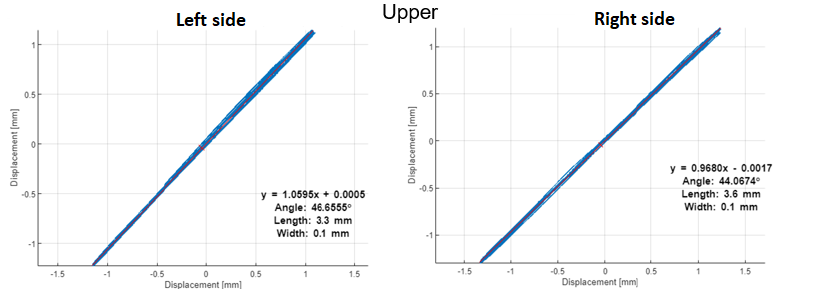
Figure 14. Orbits before repair.